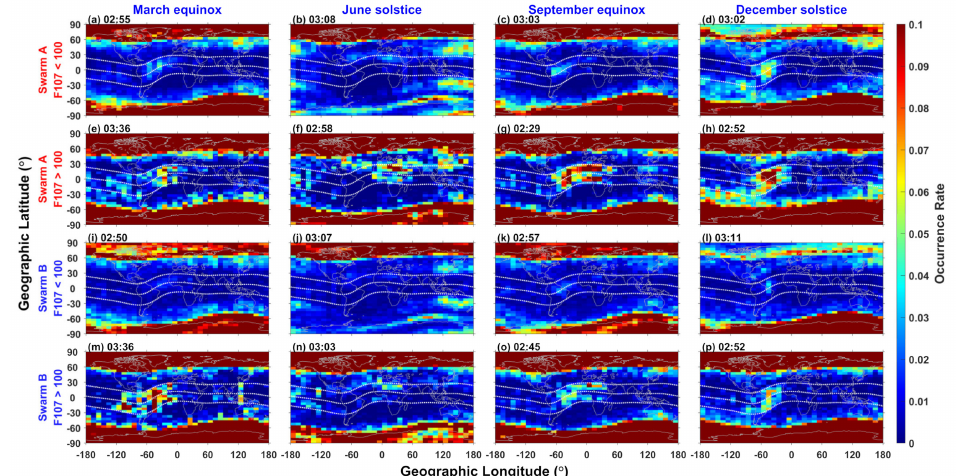
Figure 5. Same as Figure 2 but for ROTI after midnight. The panels from top to bottom show results for Swarm A (F107 < 100, ( a – d )), Swarm A (F107 > 100, ( e – h )), Swarm B (F107 < 100, ( i – l )), and Swarm B (F107 > 100, ( m – p )), from left to right show results at March equinox, June solstice, September equinox, and December